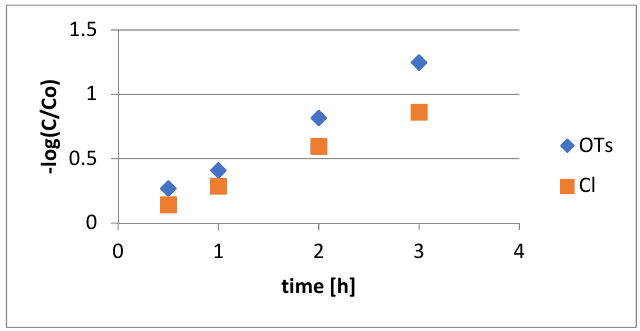
Figure 2. Pseudo-first order plots for conversion of 13 (chloro) and 18 (tosylate) into 34a/35a.